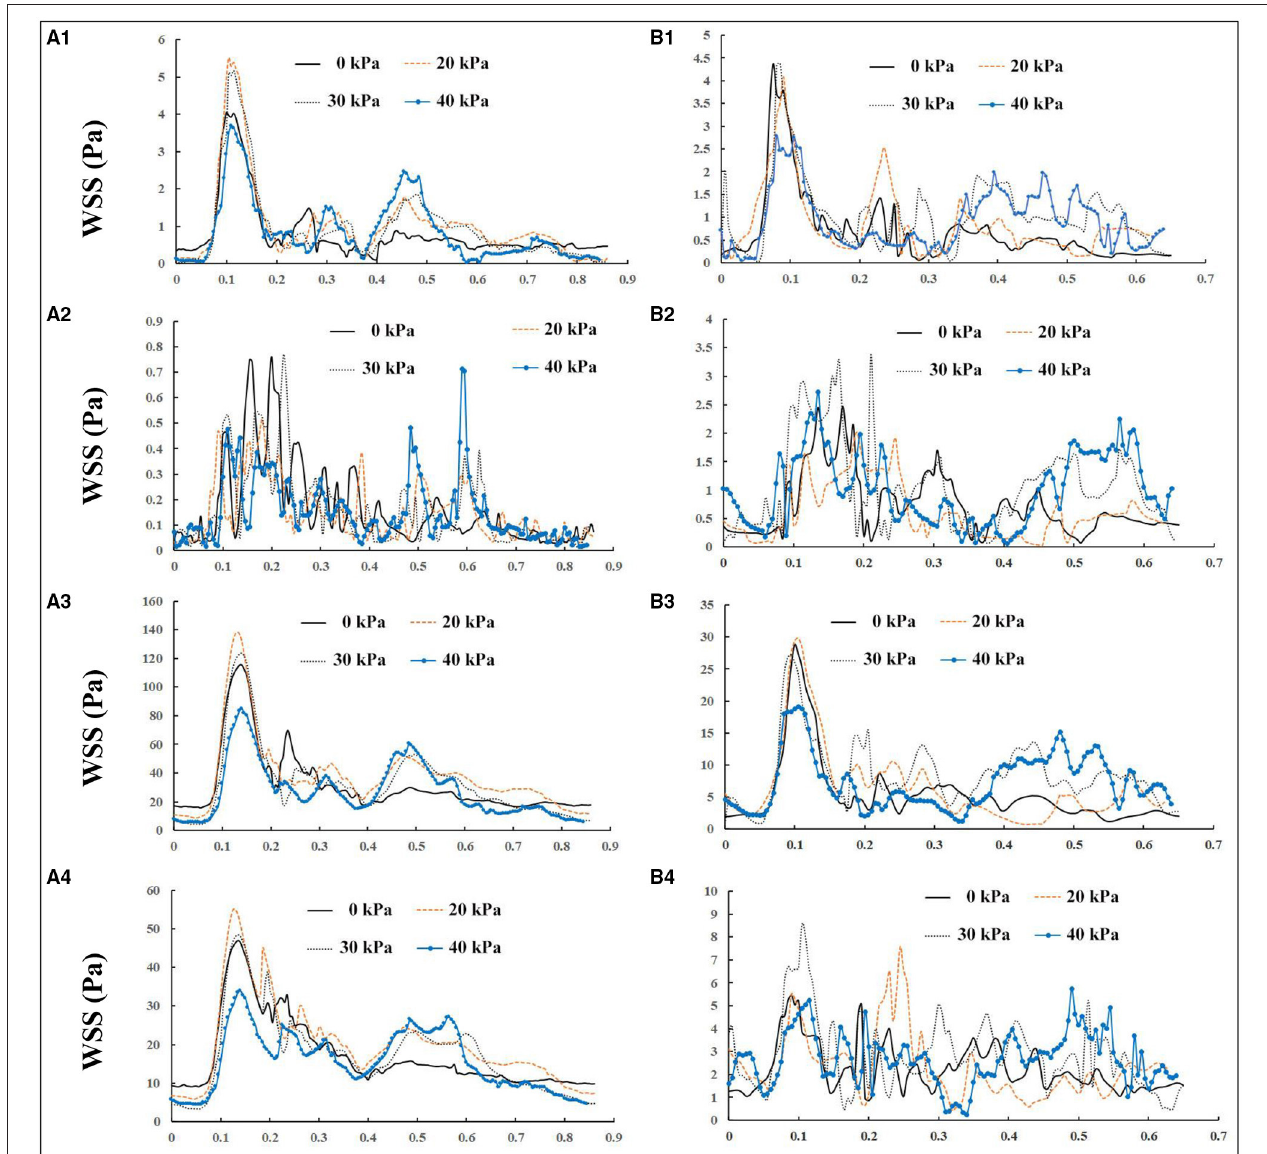
FIGURE 4 | Wall shear stress (WSS) variations in one cardiac cycle before and during enhanced external counterpulsation (EECP) with incremental cuff pressures: (A, B) represent a healthy subject and a patient, respectively; 1, 2, 3 , and 4 represent the proximal common carotid artery (CCA), outer wall of the internal carotid artery (ICA) bulb, apex, and inner wall of proximal external carotid artery (ECA),